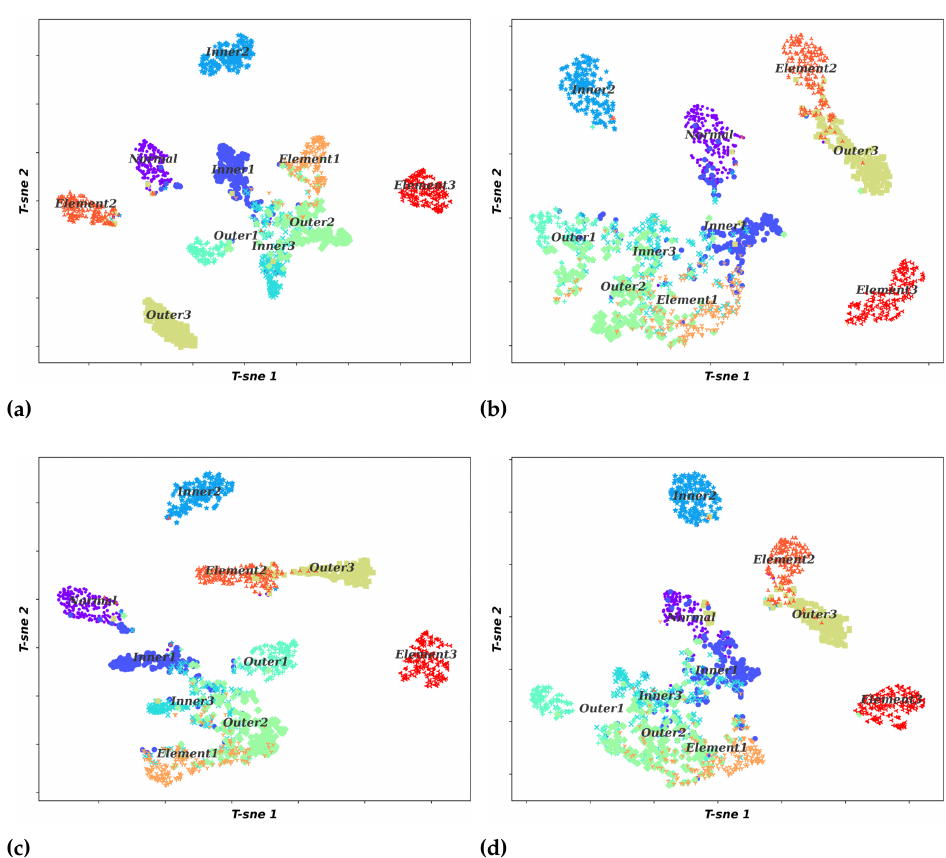
Figure 13. Two-dimensional visualization of the learned features by t-SNE. ( a ) Proposed method; ( b ) VGG19; ( c ) ResNet50; ( d )